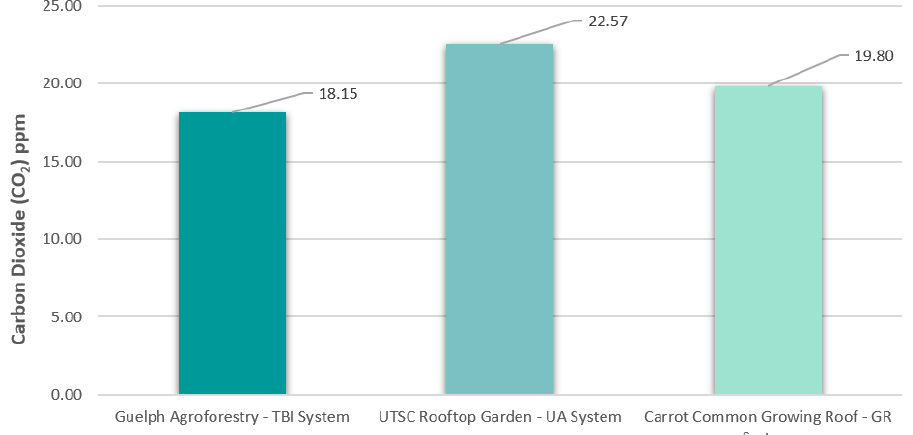
Figure 10. Average nitrogen dioxide (CO 2 ) reduction in parts per millions (ppm) from June to October 2017—Tree-based Intercropping (TBI) System: Guelph Agroforestry Research Station; Urban Agriculture (UA) Systems: UTSC Rooftop Garden; and Green Roof (GR) Systems: Carrot Common Growing Roof.